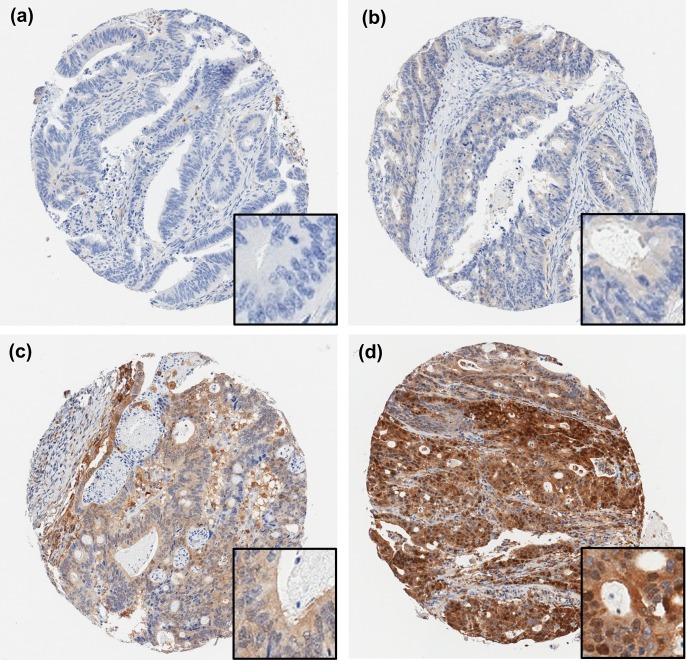
Representative tissue microarray cores showing STAT1 immunohistochemical staining.(a) Negative, (b) weakly positive, (c) moderately positive, and (d) strongly positive staining. Original magnification: 100× (insert, 400×).